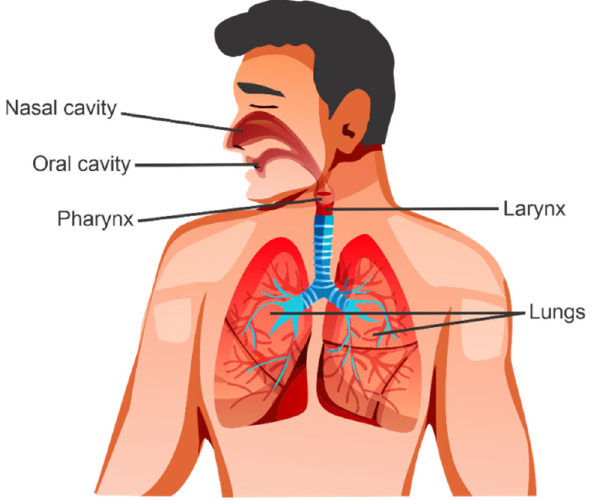
Figure 1. Organs involved in mouth sound production. Air powered by the lungs passes through the pharynx, larynx, and oral and nasal cavities, causing resonances and vibrations audible to human hearing.